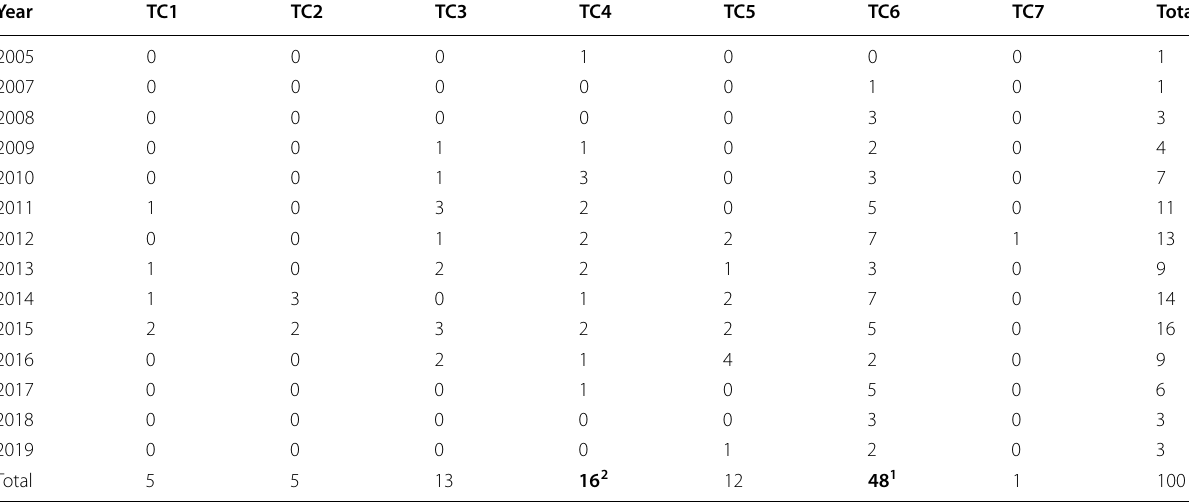
Table 6 Frequencies of highly cited publications’ research topic distributions over the years